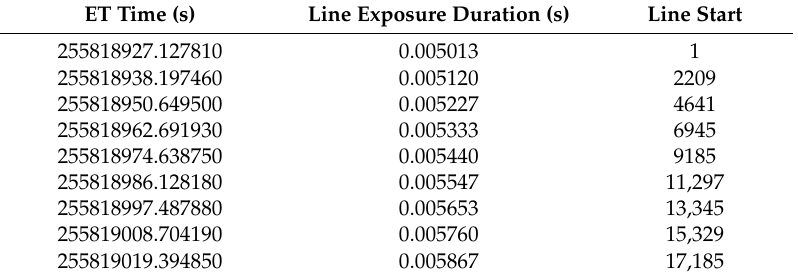
Table 2. Line exposure duration of the HRSC linear pushbroom imagery for orbit 5273. ET: emphasis